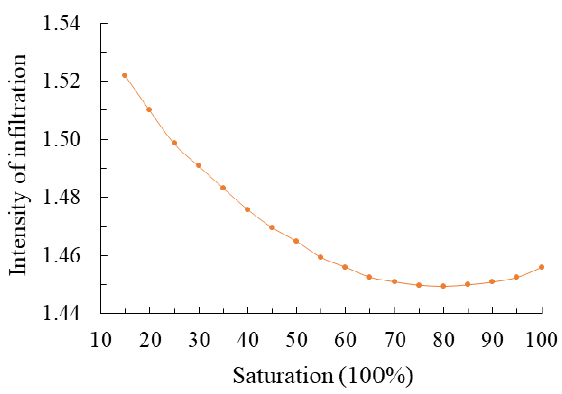
Figure 14. Diagram of infiltration intensity with saturation degree.